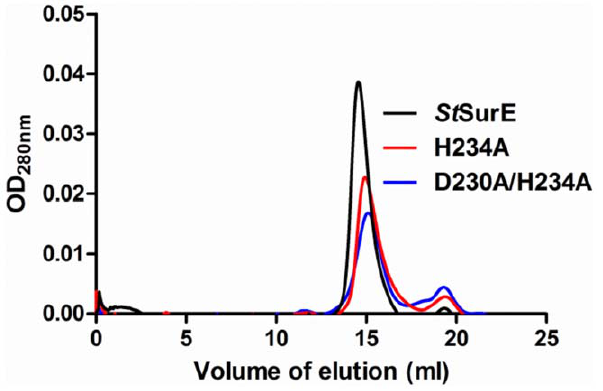
Figure 2. Characterization of the St SurE mutants. Gel filtration profile showing wild type, H234A and D230A/H234A mutant proteins eluting around 15 ml, which corresponds to molecular weight of a dimer (57